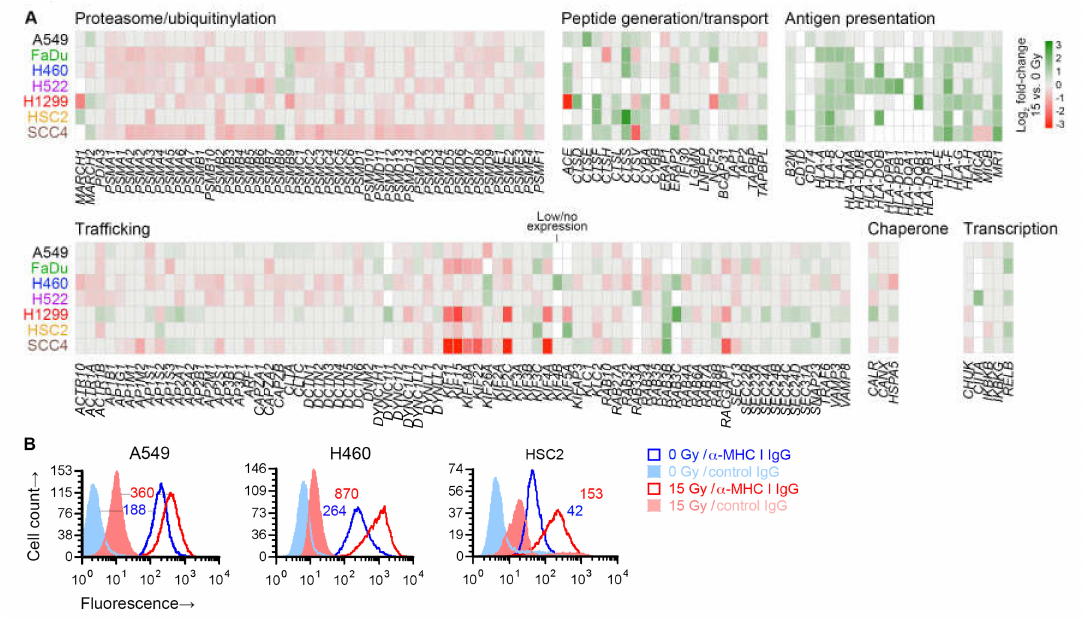
Figure 7. E ff ect of radiation on antigen processing and presentation genes. ( A ) Heatmap shows e ff ect of 15 Gy radiation (log 2 fold-change, compared to untreated cells (0 Gy)) on expression in indicated cell lines of 176 genes involved in antigen processing and presentation, of which expression was detected in at least one cell line. Genes are grouped by their function. Genes for which there was no e ff ect (nominal p ≥ 0.05 in paired likelihood ratio test in edgeR) are shown in grey. Those with p < 0.05 are colored as per the displayed scale. Genes of which the expression was considered too low were not examined and are shown in white. ( B ) Cell surface expression of class I major histocompatibility complex (MHC I) proteins on viable 15-Gy-treated and untreated cells is depicted for three cell lines with representative direct fluorescence flow cytometry histograms. Viable cells were identified by 7 -amino-actinomycin D staining. MHC I proteins were detected with a phycoerythrin (PE)-conjugated monoclonal IgG antibody. Separate portions of the same cell samples were examined for binding of a PE-conjugated negative control IgG. Geometric mean fluorescence intensity values for MHC I normalized against the negative control by subtraction are noted. For both A and B , sub-confluent adherent cultures of indicated cell lines that had been grown in parallel to same cell density were treated with one dose of 0 or 15 Gy X-rays. After four days, adherent cells were collected by scraping and